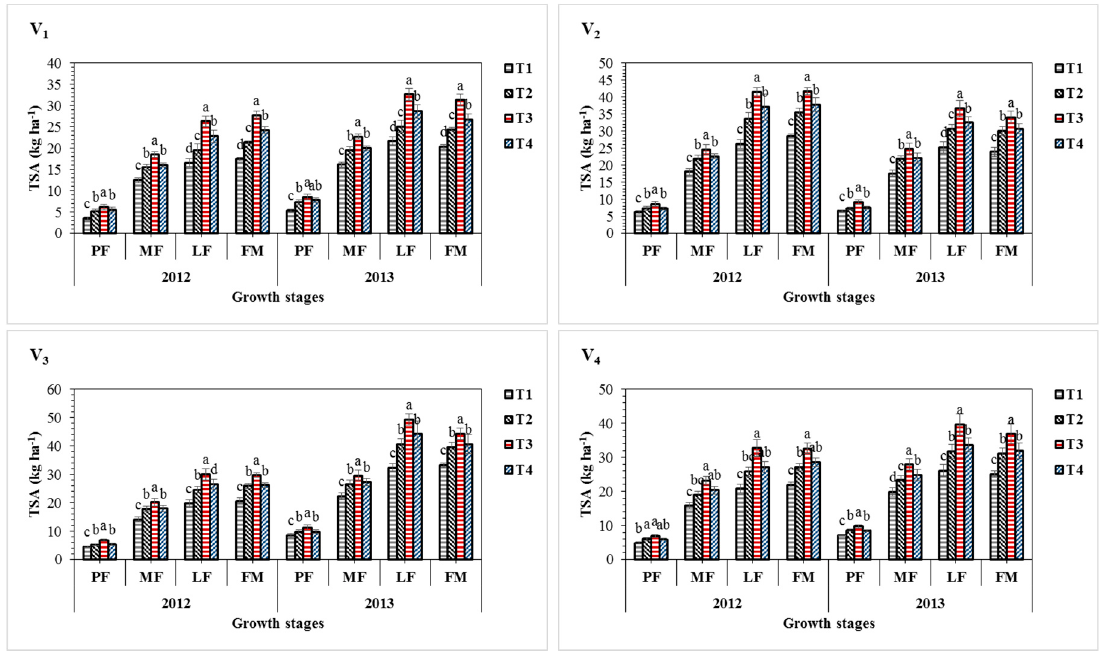
Figure 4. Total sulphur accumulation (TSA) in sesame varieties as affected by sulphur treatments during 2012 and 2013 cropping seasons. PF, MF, LF and FM refer to four sesame growth stages pre-flowering, mid-flowering, late-flowering and full-maturity described by Langham (2007), V 1 , V 2 , V 3 and V 4 represent four sesame varieties SG-27, SG-30, SG-36 and SG-51 and T 1 , T 2 , T 3 and T 4 , represent four sulphur treatments 20, 30, 40 and 50 kg S ha − 1 respectively. Within a bar, different lowercase letters show a significant difference ( p < 0.05) between treatments. All the values are average of four replicates.